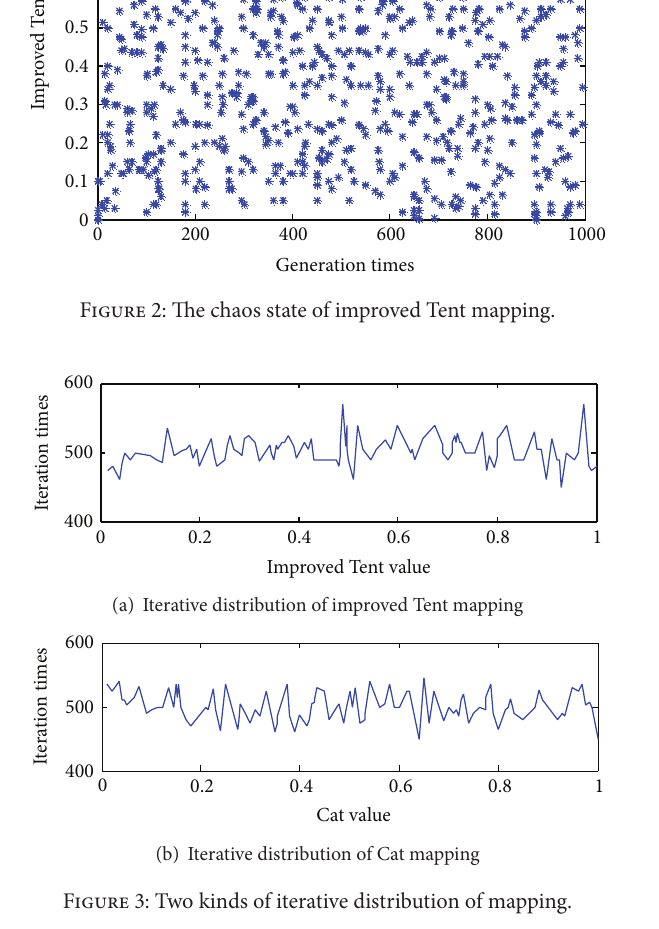
Thus the Cat map has the characteristics of chaotic. Figure 3 presents iterative distribution of improved Tent and Cat